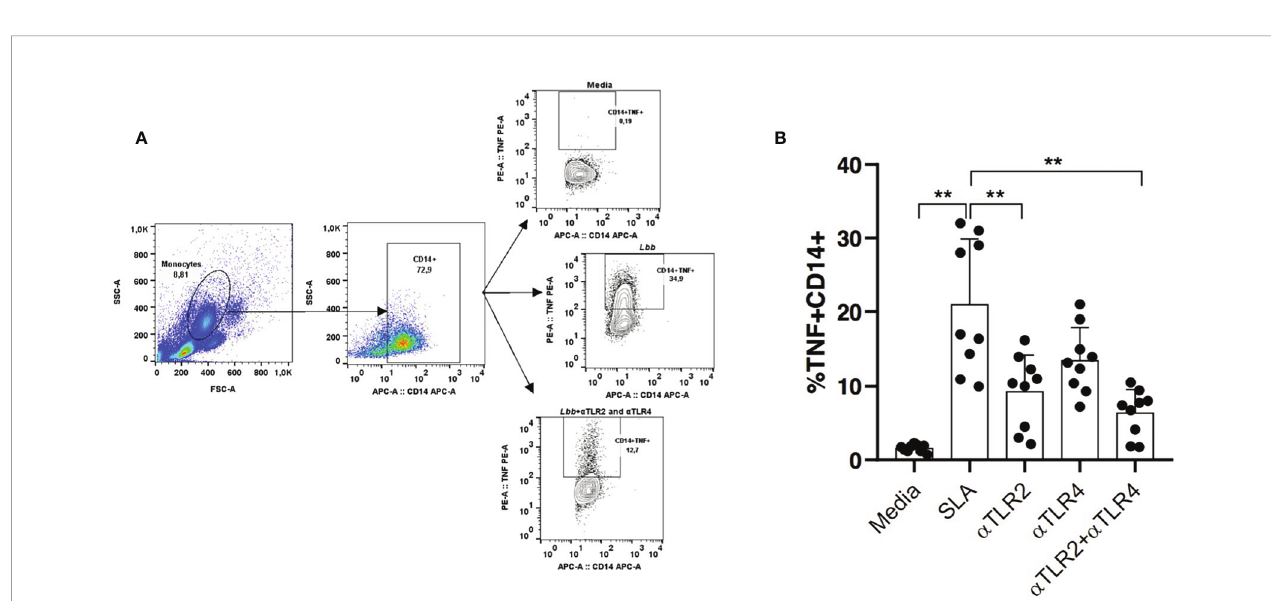
FIGURE 6 | The TNF production after stimulation with leishmania soluble antigen (SLA) and TLR2 and TLR4 neutralization. Monocytes from CL patients (n = 10) were treated or not with anti-TLR2 and anti-TLR4 antibodies. Cells were stimulated with SLA for 8 hours. (A) The positive fl orescence in the population cells were obtained by the strategy using FMO (Florescence Minus One). The frequency of cells expressing TNF in CD14+ cells (B) was performed by the fl ow cytometry technique. All p values were obtained using Wilcoxon ’ s statistical test